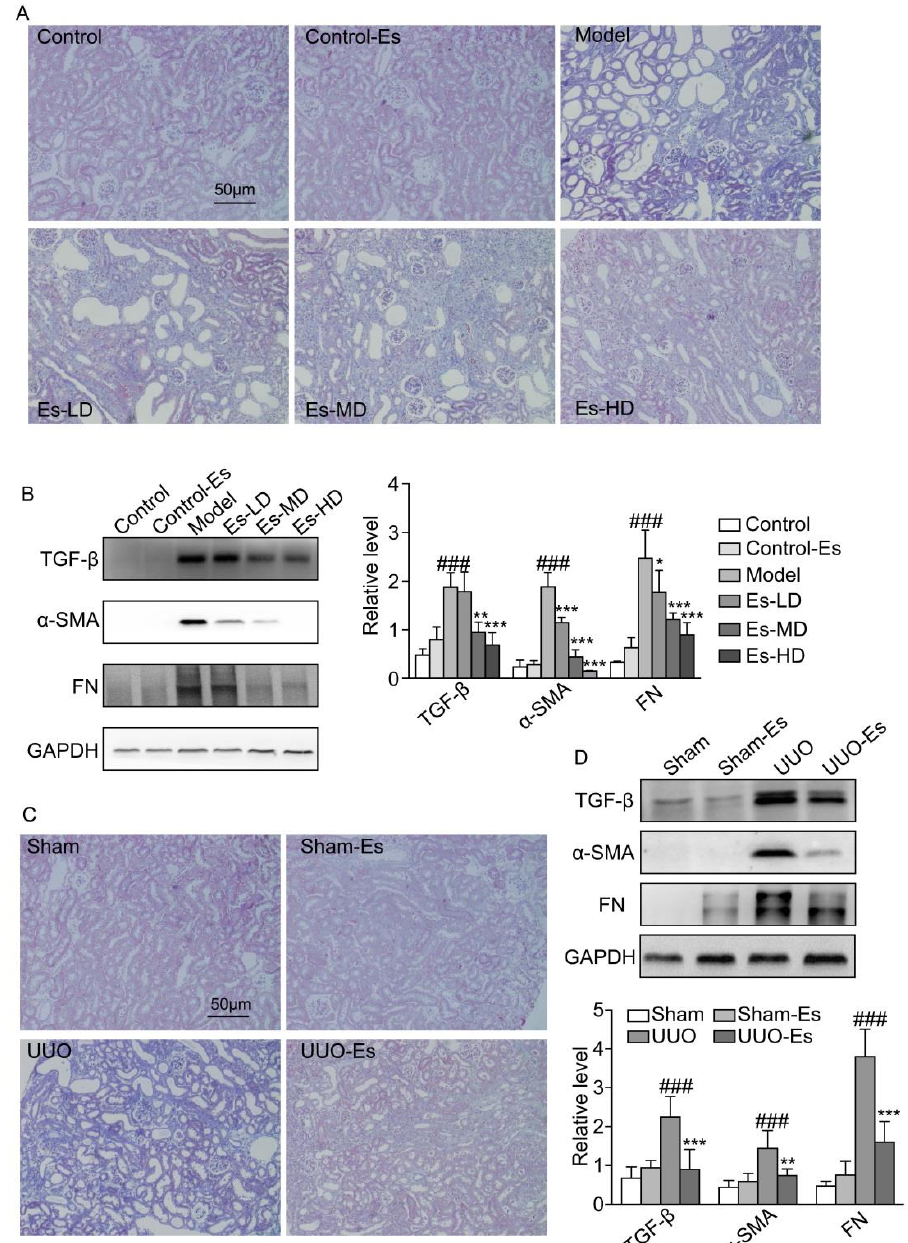
Figure 3. E ff ects of esculetin on renal fibrosis. ( A ) Photomicrographs of Masson’s trichrome stained kidney tissues in HUA model mice (magnification 200 × ). ( B ) Western blots of fibrosis-related proteins in HUA model mice. Vertical bars show data with mean ± SD ( n = 5). ### p < 0.001 vs. Control. * p < 0.05, ** p < 0.01 and *** p < 0.001 vs. Model. ( C ) Photomicrographs of Masson’s trichrome stained kidney tissues of UUO model mice (magnification 200 × ). ( D ) Western blots of fibrosis-related proteins in UUO model mice. Means ± SD ( n = 5). Vertical bars show data with mean ± SD ( n = 5). ### p < 0.001 vs. Sham. ** p < 0.01 and *** p < 0.001 vs. UUO.